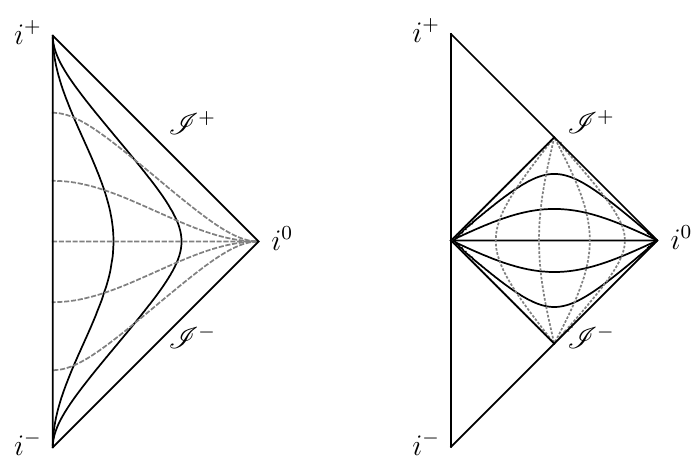
Figure 1 . Penrose diagrams of Minkowski (cid:13)at spacetime M d . (Left) The dashed and thick curves denote the constant Cartesian time t and radial r slices respectively. As we see all the constant t curves meet the asymptotic spatial in(cid:12)nity i 0 with a zero slope. (Right) The patch covered by the de Sitter slicing. The solid lines are constant (cid:28) slices, while dotted lines are constant (cid:26) hyperboloids. The de Sitter slicing does not cover future and past timelike in(cid:12)nities i (cid:6)